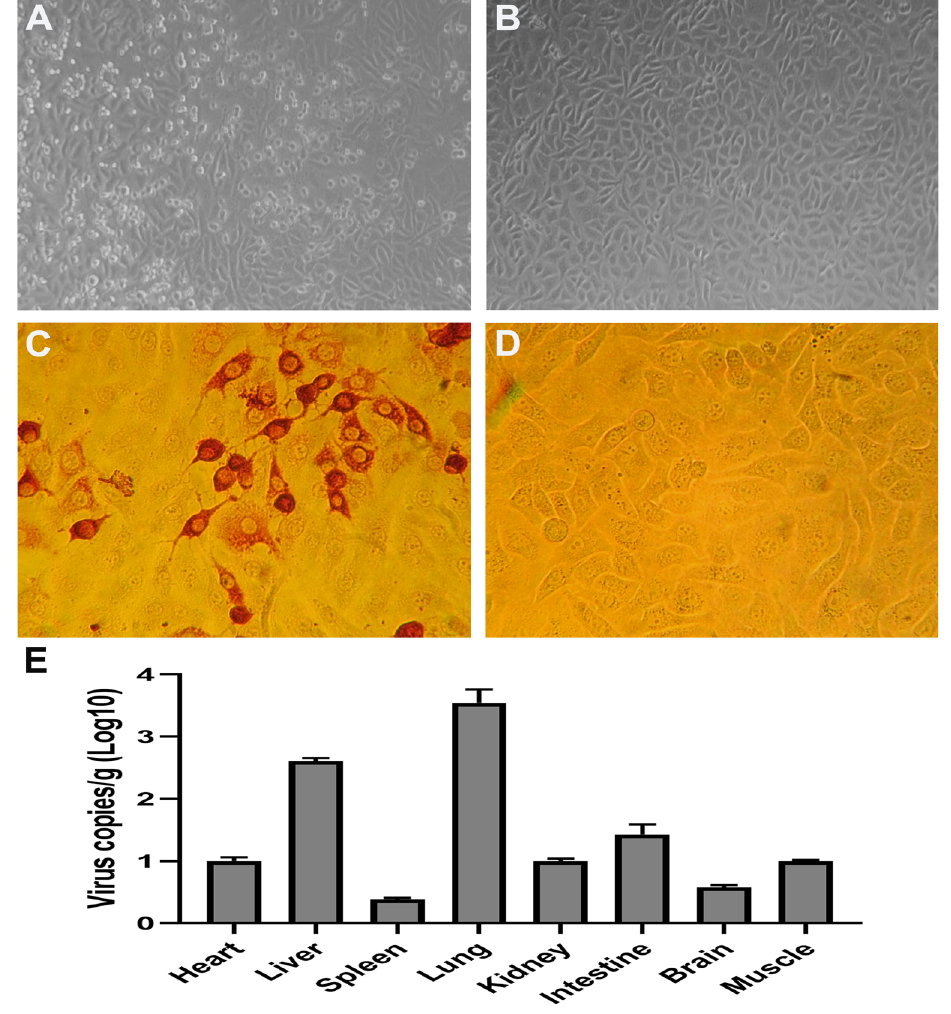
Figure 4. Recovery of the virus from infected mice. Tissue samples from infected mice were collected, homogenized, and used to inoculate the Vero cells. Tissue samples from non-infected mice were used as control. Typical cytopathic effects (CPE) were usually observed in the 36–48 h post inoculation ( A ). No CPEs were noticed in Vero cells inoculated with normal mice tissue samples ( B ). IPMA revealed the strong signals in Vero cells infected with CEV-JL14 ( C ). No signals were observed in the control groups ( D ). Three-day-old ICR suckling mice were injected with 2 × 10 6 TCID 50 CEV-JL14 by subcutaneous injection. Tissues including heart, liver, spleen, lung, kidney, intestine, brain, and muscle were harvested after 5 dpi for RT-qPCR. Viral loads in the corresponding tissues from three infected mice (5 dpi) by CEV-JL14 virus were quantitated and represented as average virus copies of log 10/g tissue ( E ).